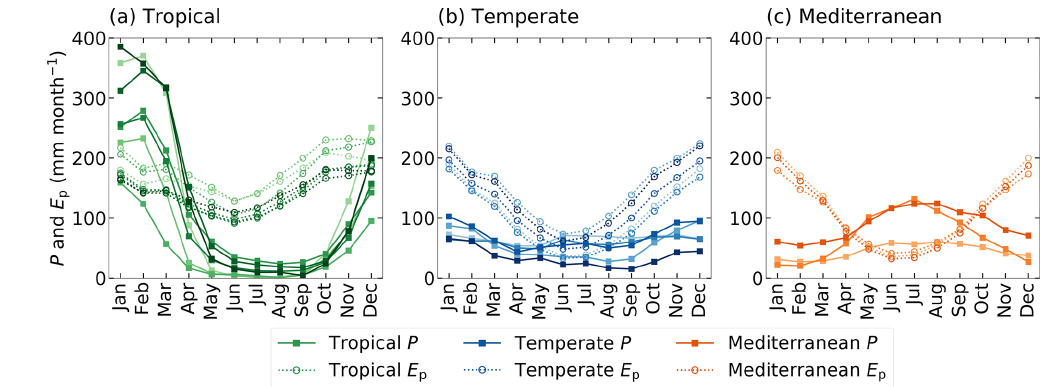
Figure 2. Monthly seasonal climatology of precipitation ( P ) and potential evaporation ( E p ) for the (a) tropical, (b) temperate and (c) Mediterranean catchments, with the solid lines representing P and the dashed lines E p , for the time series 1973–2010. The different shades indicate the 15 individual study catchments.